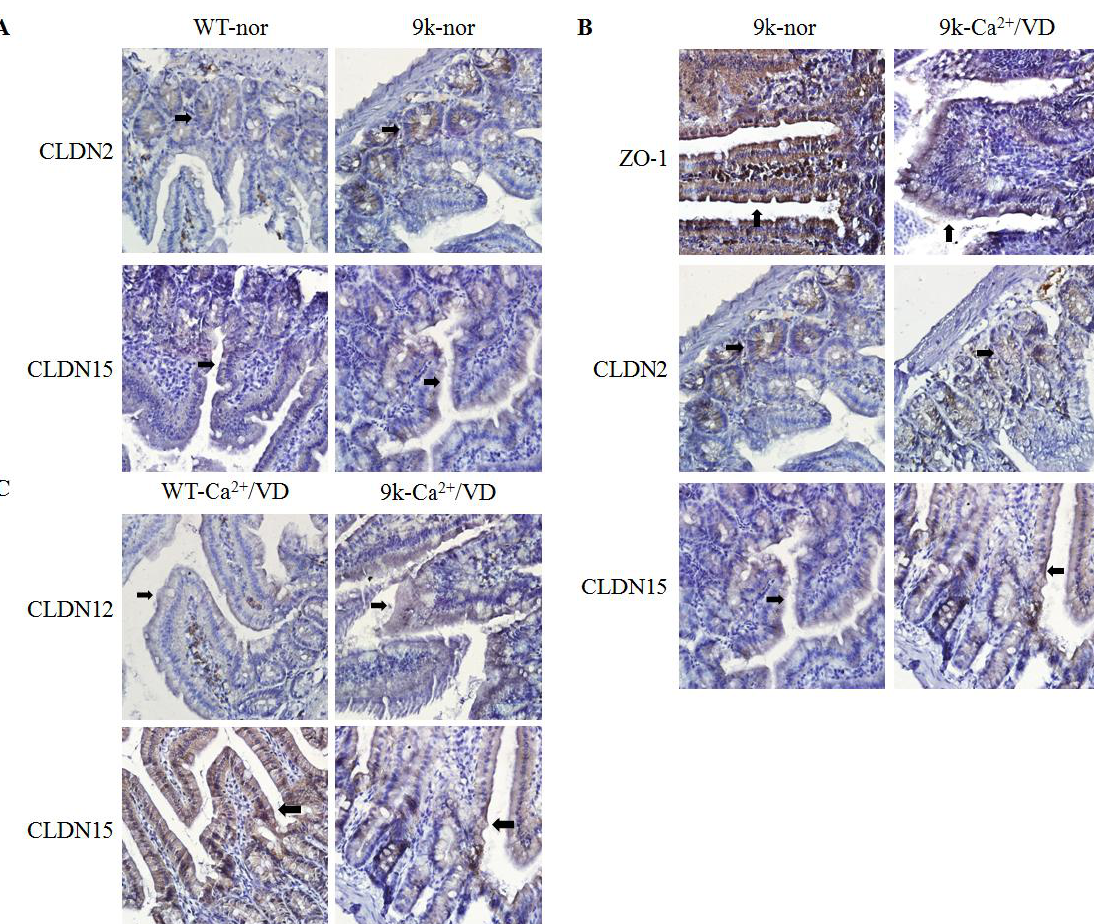
Figure 3. Localization of tight junction proteins in the duodenum. Differential localization of ZO-1, CLDN2, CLDN12 and CLDN15 was observed with immunohistochemistry. CLDN2 and CLDN15 localization was compared in the duodenum of WT and CaBP-9k KO mice fed the normal diet ( A ); The dietary effect of calcium/vitamin D deficiency on ZO-1, CLDN2 and CLDN15 localization in the duodenum of CaBP-9k KO mice was examined ( B ); Differential CLDN12 and CLDN15 localization in the duodenum of calcium/vitamin D-deficient WT and CaBP-9k KO mice was evaluated ( C ). Each slide was viewed at 400× magnification. Black arrows indicate the immuno-positive